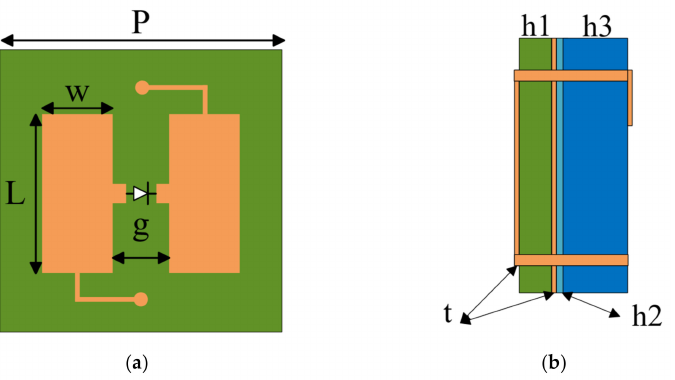
Figure 3. Unit cell structure. ( a ) Unit cell top view. ( b ) Unit cell side view.